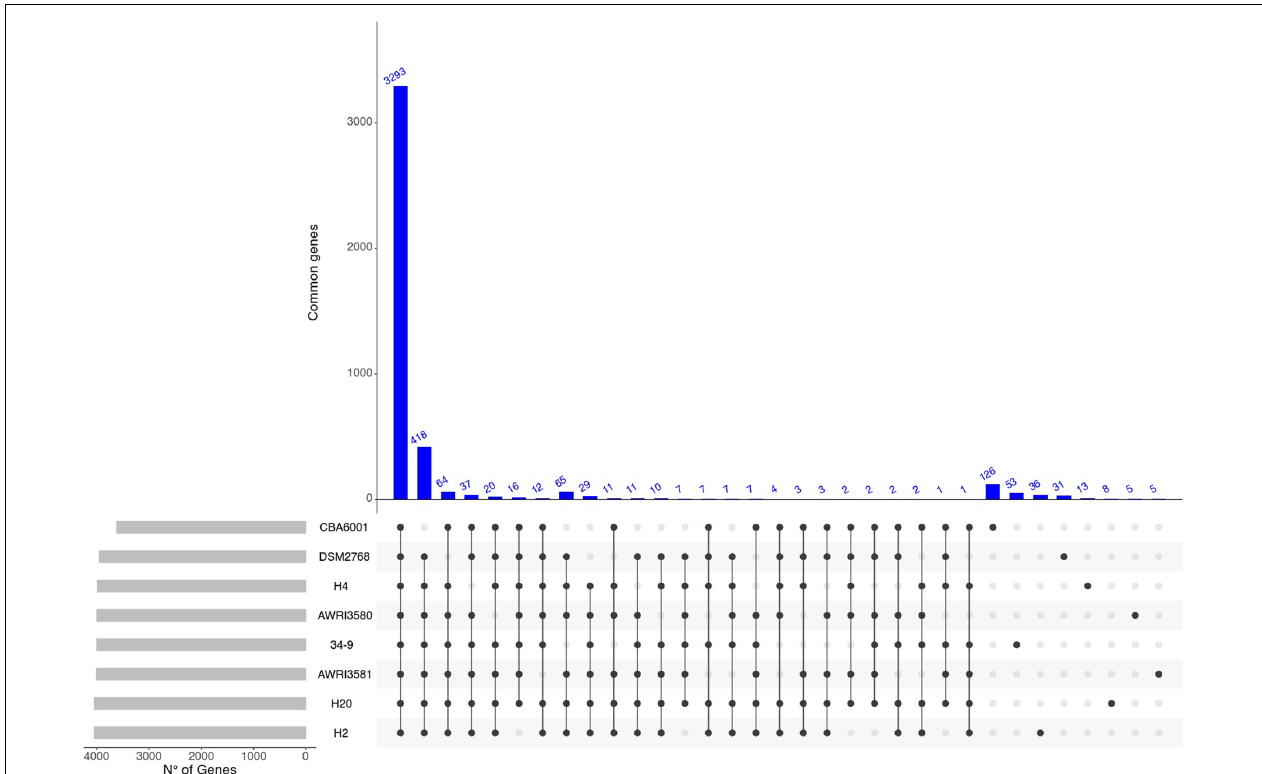
FIGURE 3 | Graphical overview of shared genes. Number of genes shared between different combinations of H. uvarum strains. Blue bars indicate the number of shared genes. Gray bars are used to show the total number of genes for each H. uvarum